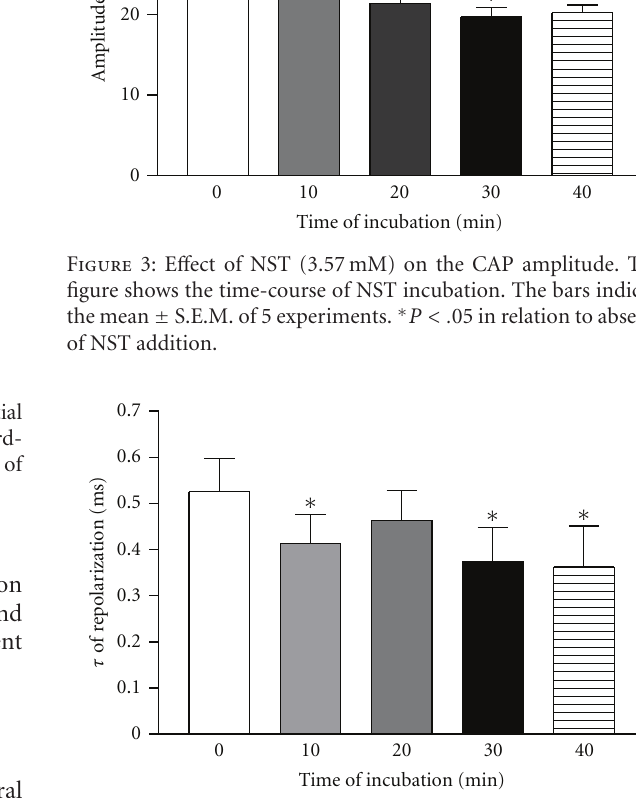
Figure 4: E ff ect of NST (3.57mM) on the time constant of CAP repolarization. This figure shows the time-course of NST incubation. The bars indicate the mean ± S.E.M. of 5 experiments. ∗ P < . 05 in relation to absence of NST